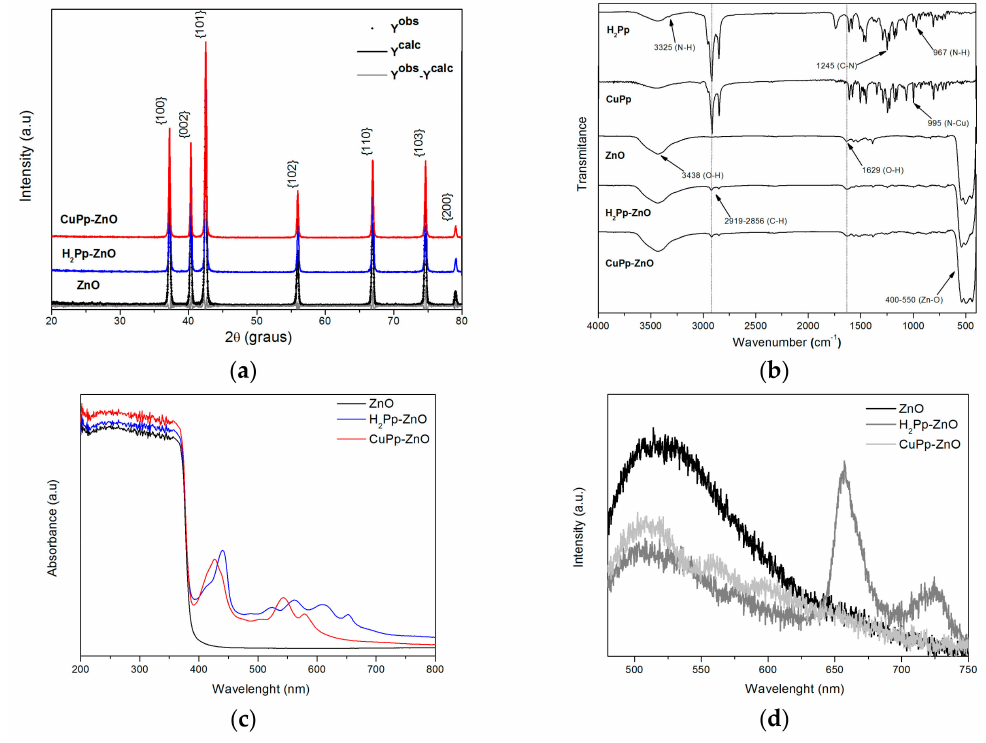
Figure 3. ( a ) XRD patterns of the photocatalysts; ( b ) FT-IR spectra; ( c ) UV-Vis reflectance spectra; and ( d ) photoluminescence